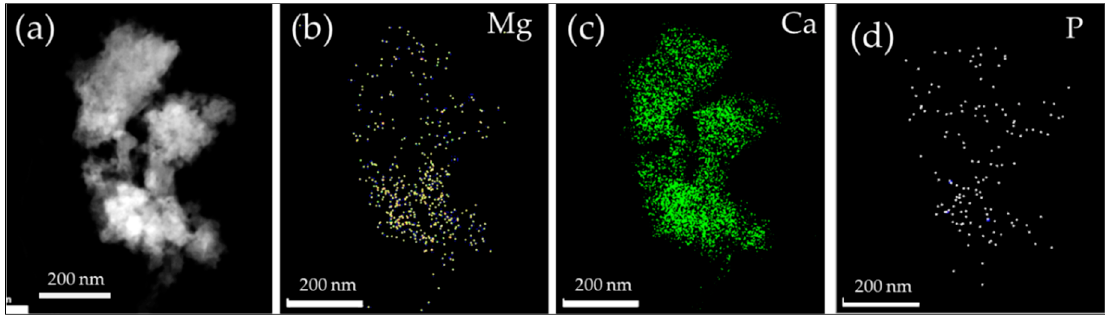
Figure 4. STEM and elemental mapping images of the biotic aragonite at a Mg / Ca molar ratio of 8: ( a ) TEM image of the biotic aragonite; ( b–d ) Mg, Ca, and P elements in the biotic aragonite. Crystals 2020 , 01 , x FOR PEER REVIEW